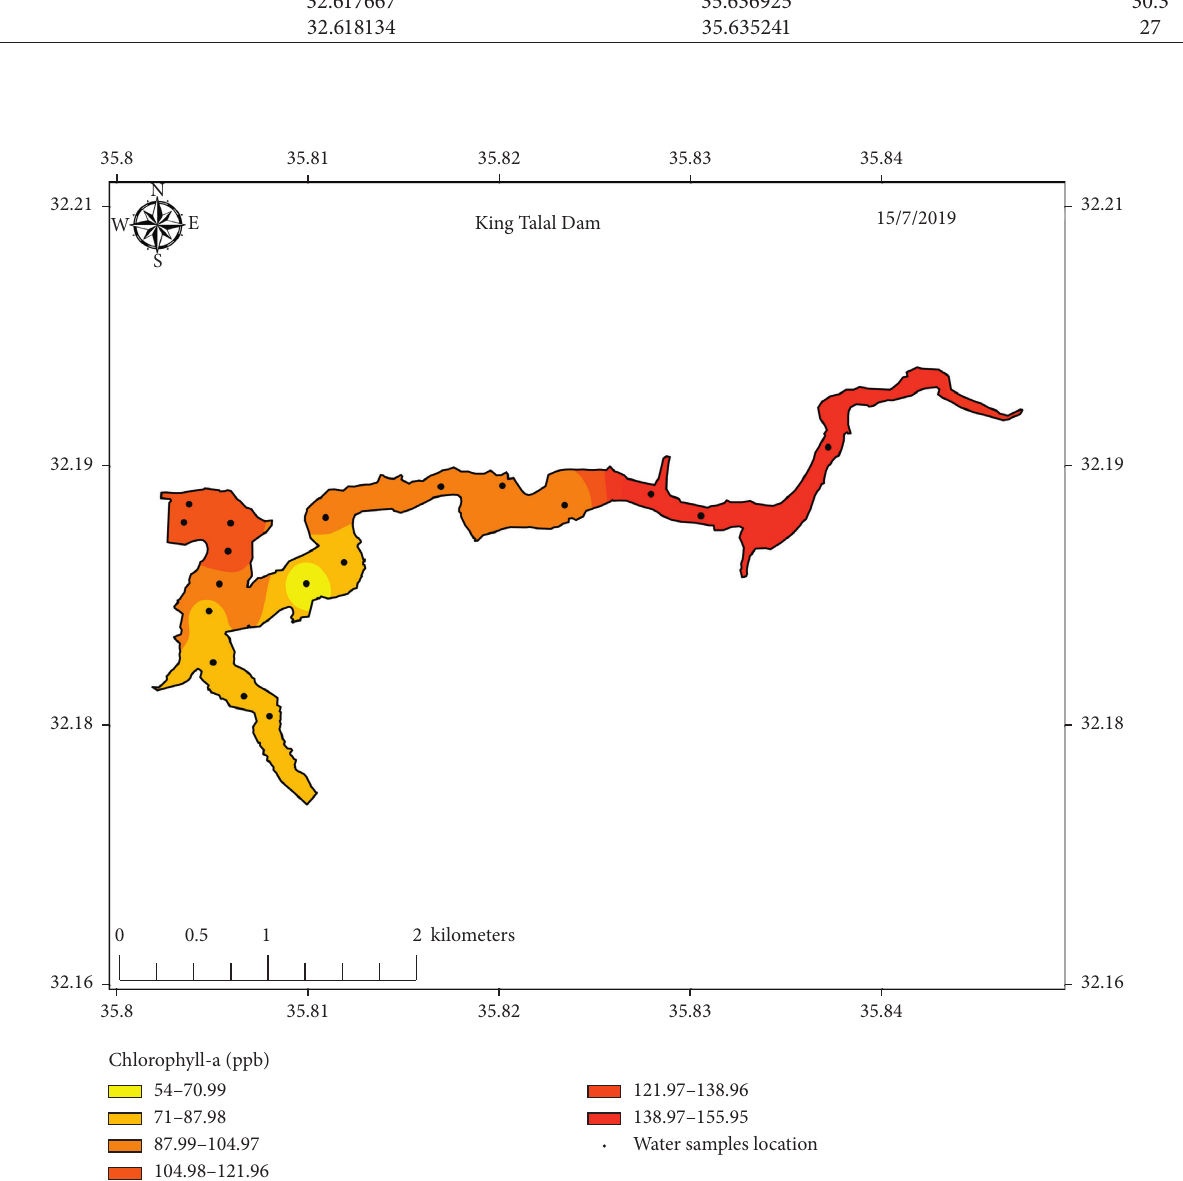
Figure 5: Concentration distribution of Chl-a through KTD’s